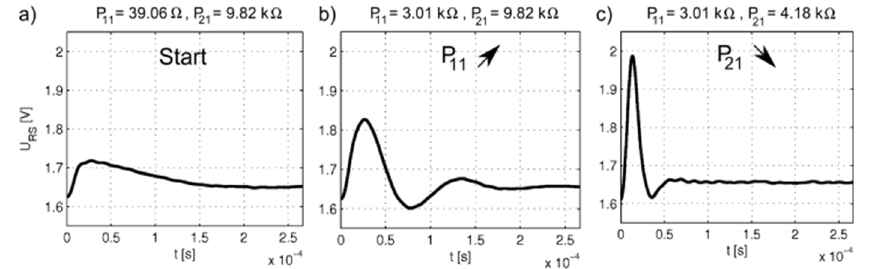
Figure 5. Successive stages of manual adjustment of dynamic properties of the hot-wire anemome- ter: ( a ) stable, slow response of the system; ( b ) oscillations in the dynamic response of the system; ( c ) optimal dynamic response of the measurement system.